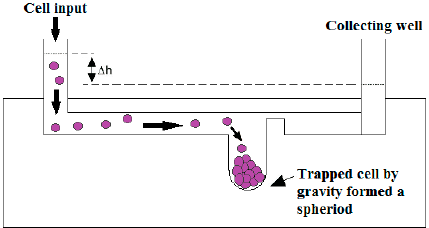
Figure 7. Schematic illustration of 3D microenvironment platform to generate spheroid cancer cells. Reproduced after [85].